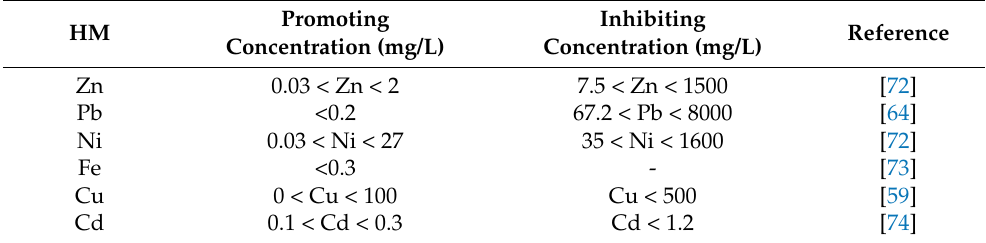
Table 3. Promoting and inhibiting concentrations of heavy metals (HMs) on anaerobic digestion (AD).